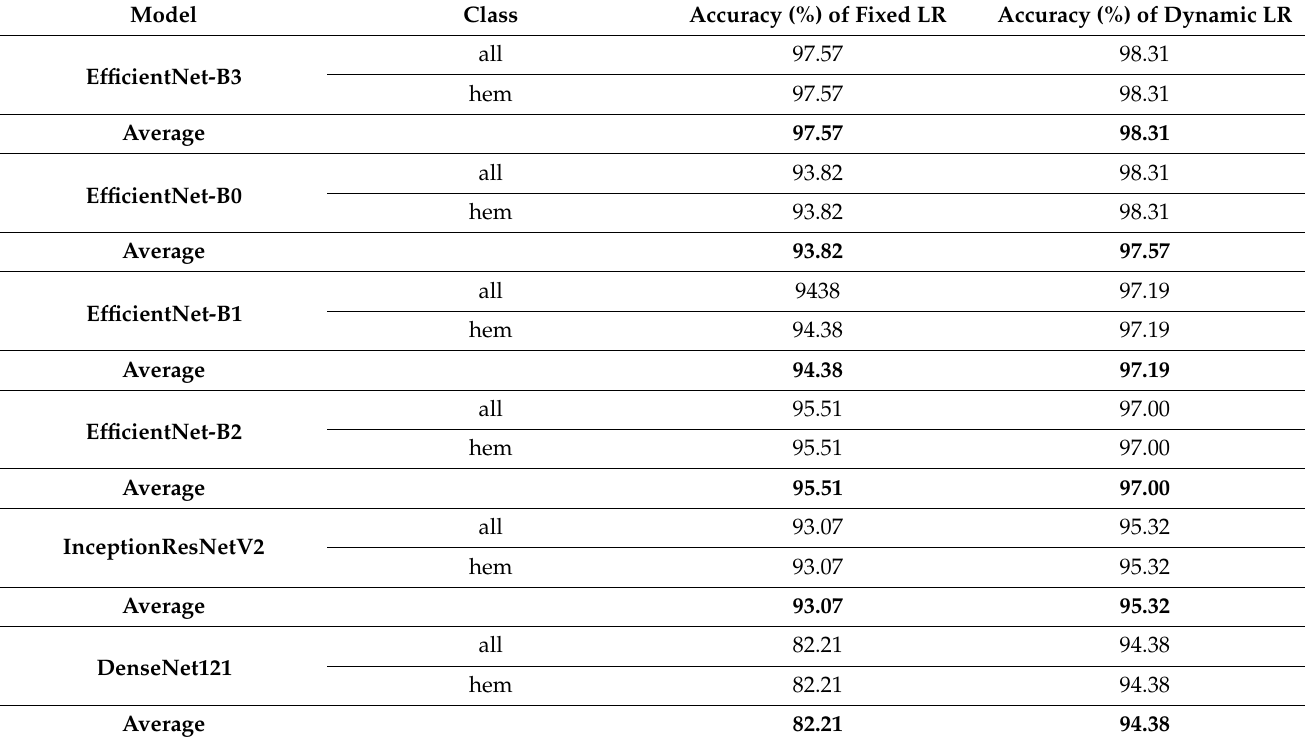
Table 4. Comparison of accuracy of the six CNN models using the proposed dynamic LR and using the fixed LR for ALL